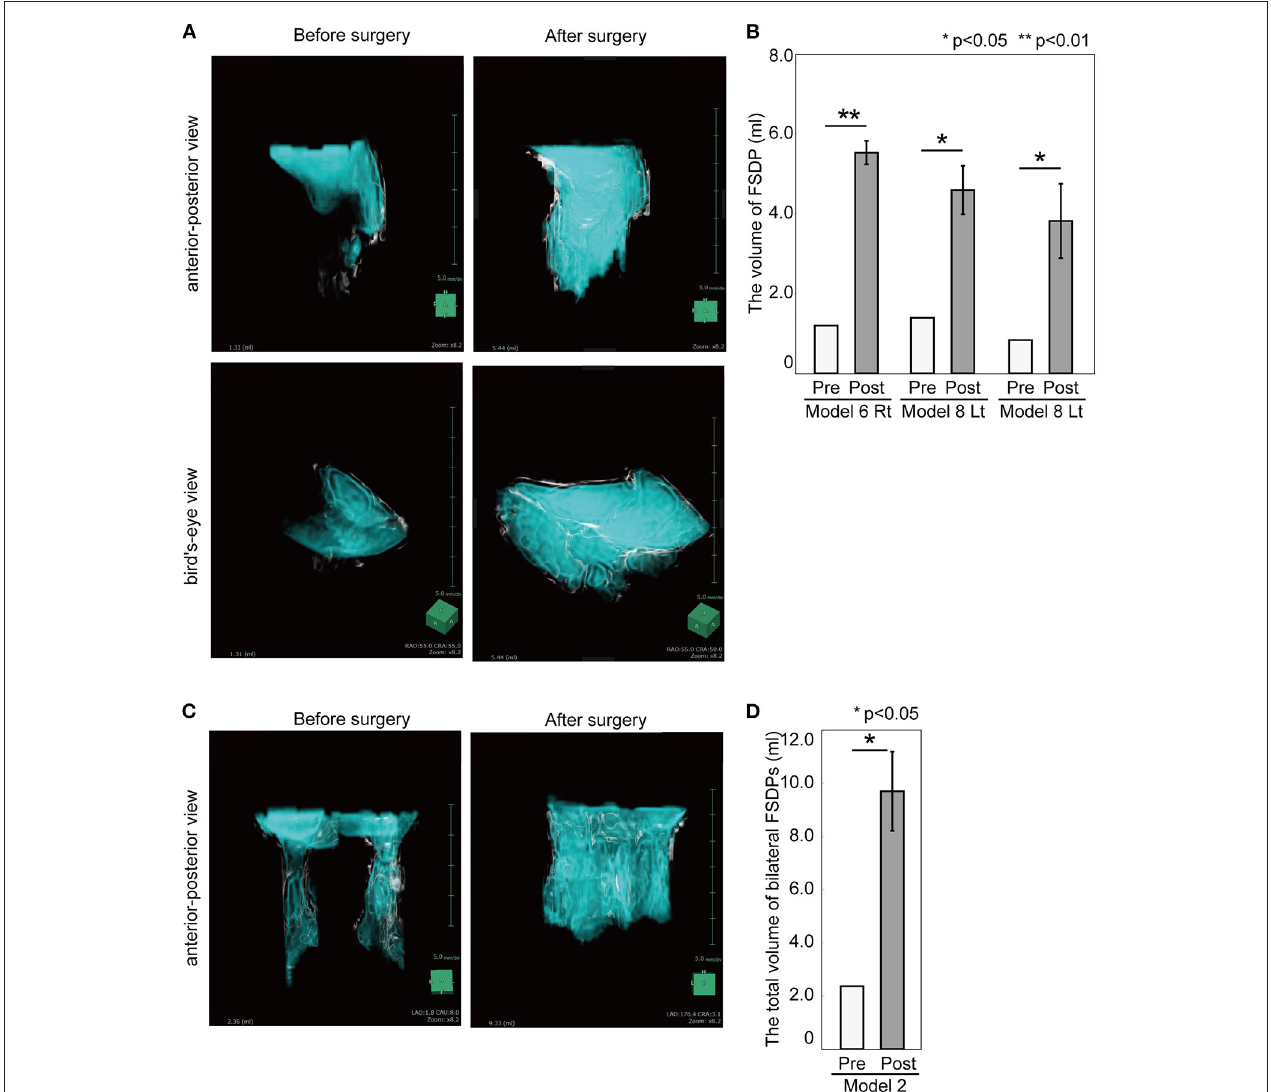
FIGURE 3 | The volume of FSDP before and after the frontal sinusotomies and the frontal drill out. (A) 3D computed graphic images of right FSDP in the model 6 before and after the sinusotomies. (B) The volume of FSDP in 3D sinus models was significantly improved after the frontal sinusotomies than before the procedure. P -values for indicated comparisons were determined by t -test. * p < 0.05, ** p < 0.01. (C) 3D computed graphic images of bilateral FSDP in the 3D sinus models before and after the frontal drillout (the model 2). (D) The total volume of bilateral FSDPs was also significantly improved after the frontal drillout. P -values for indicated comparisons were determined by t -test. * p <